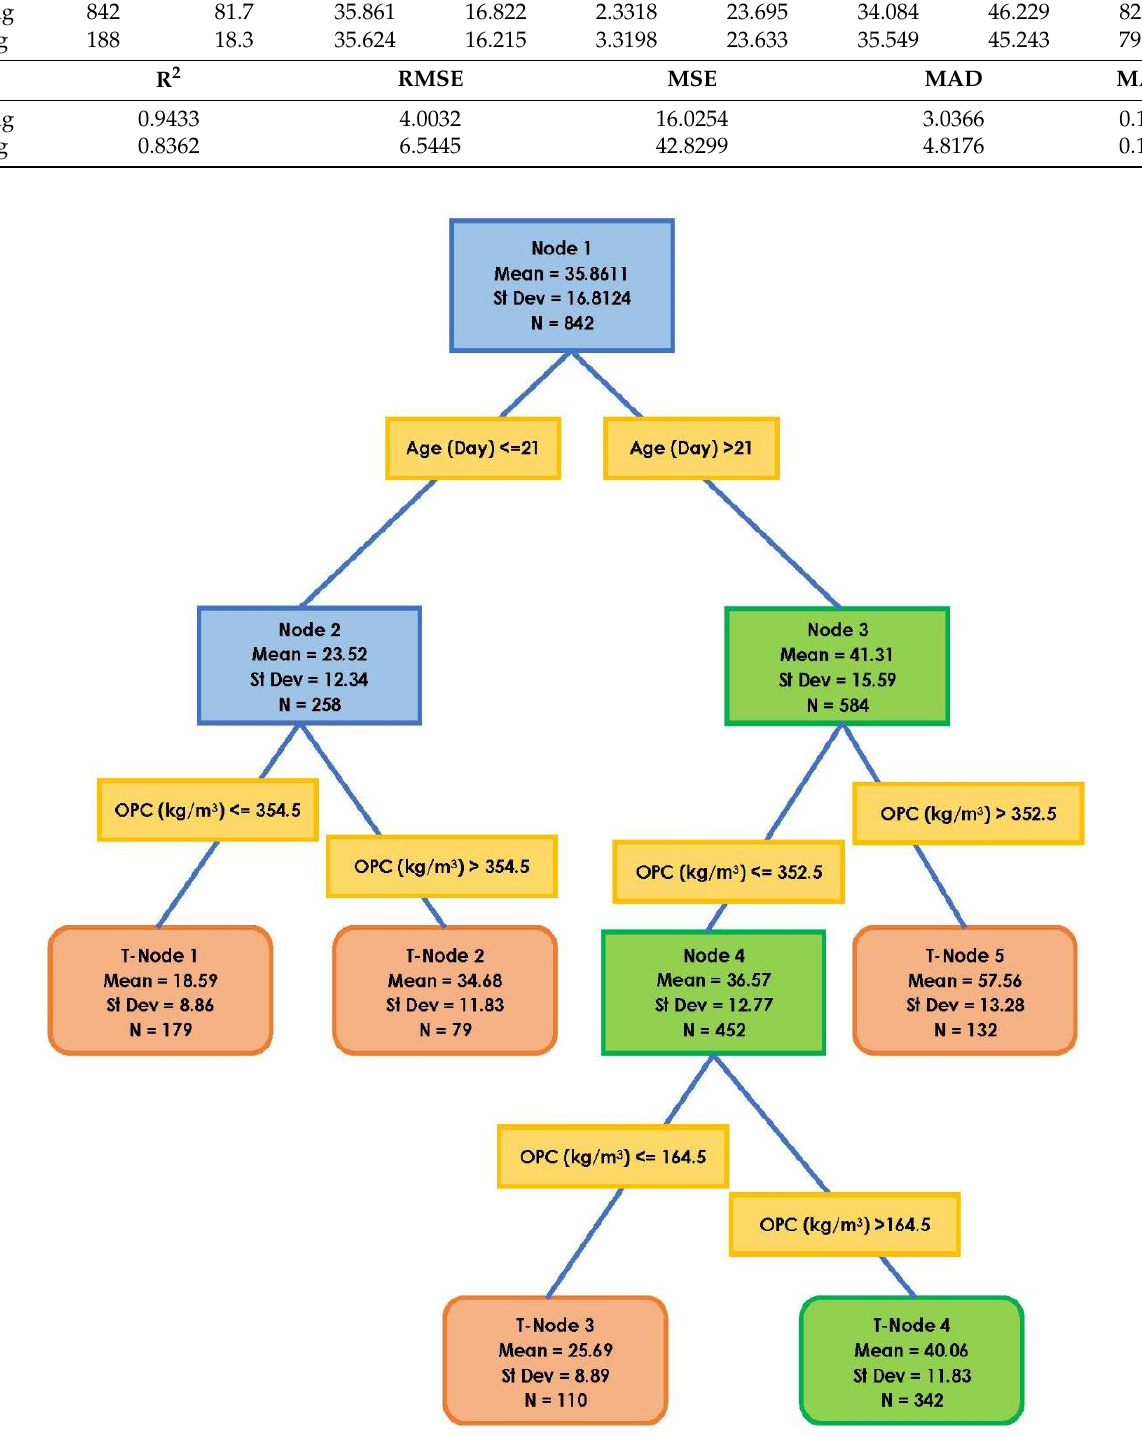
Figure 7. Decision Tree Diagram using DT Model for Training Dataset.